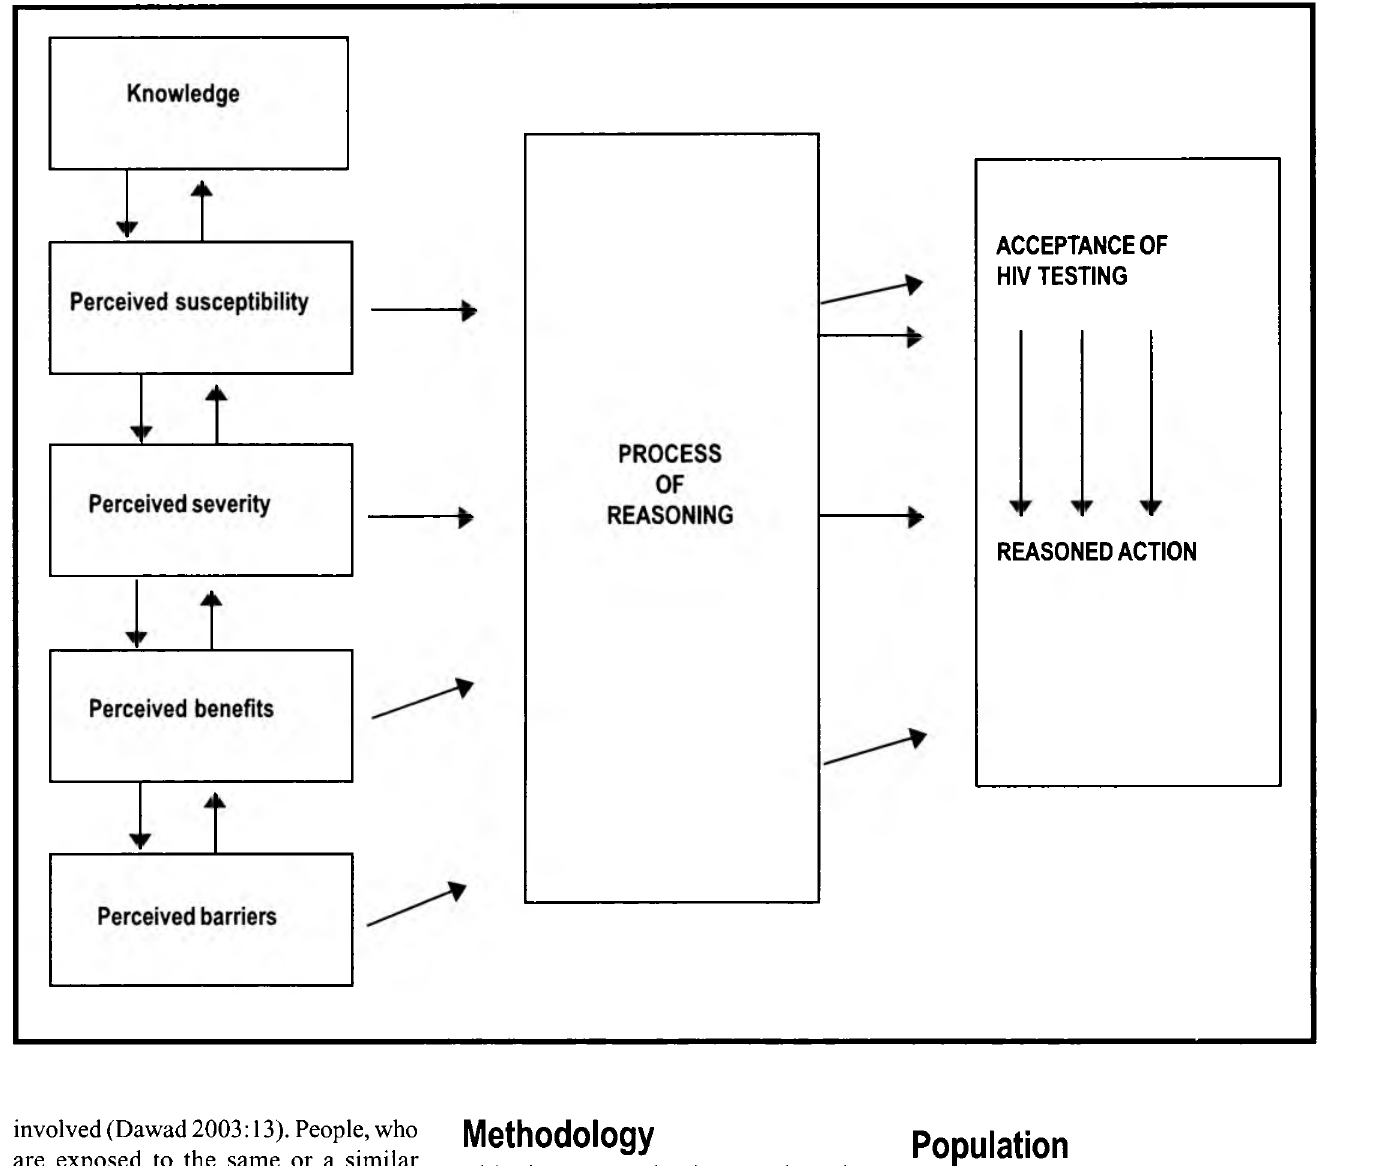
Figure 1: Adapted from the Health Belief Model by Maiman and Becker